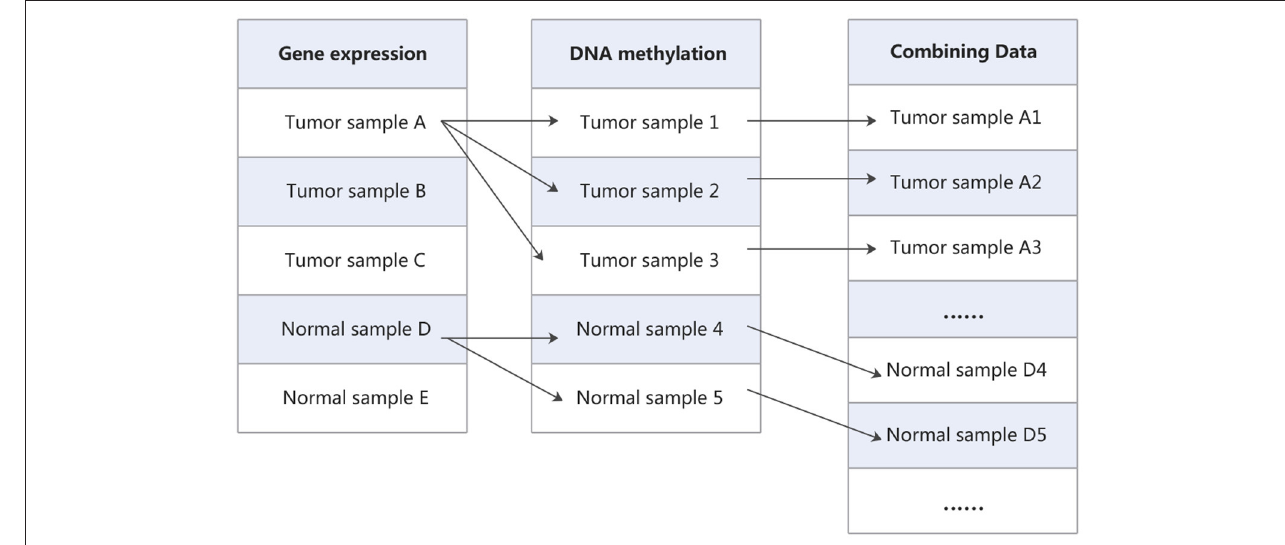
FIGURE 2 | The process of combining data.